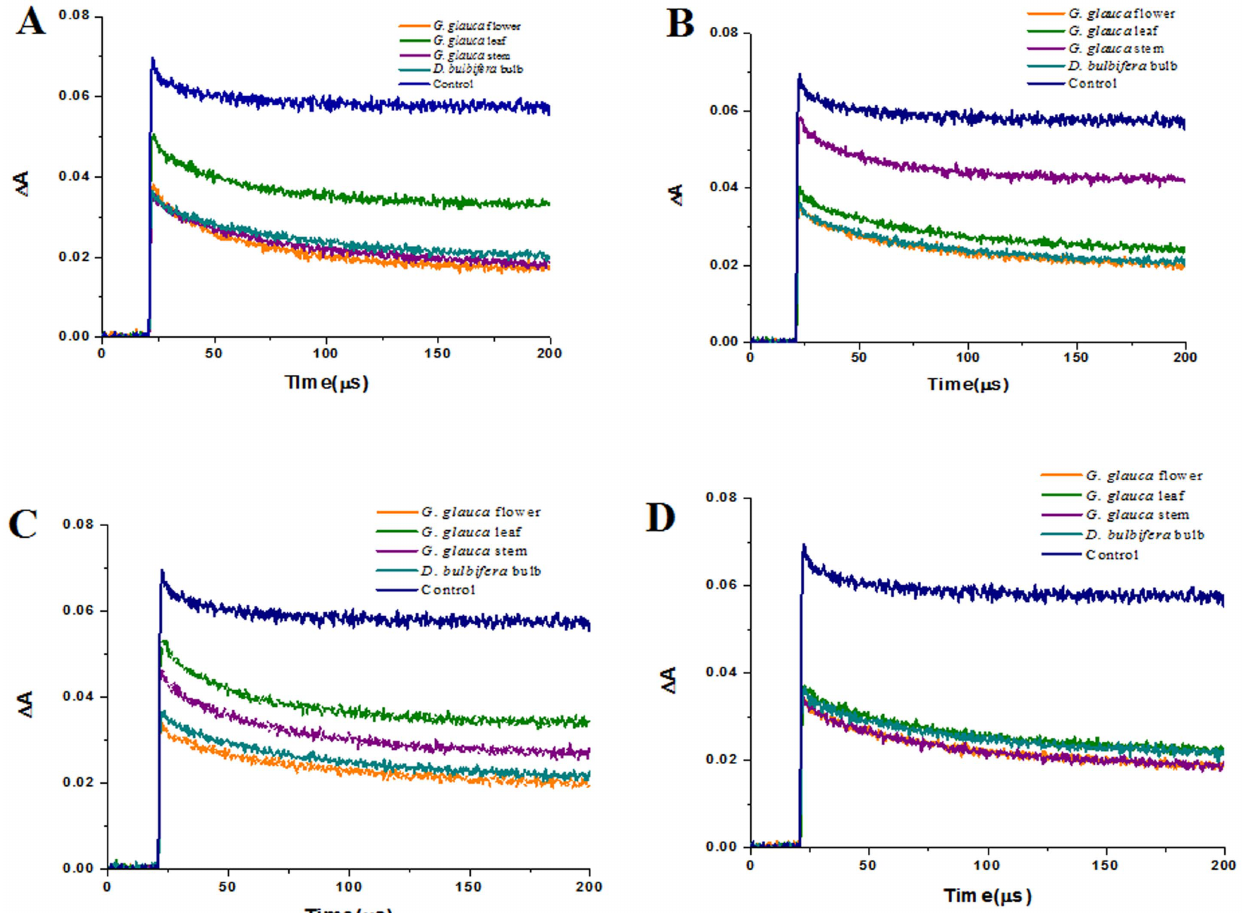
Figure 3. Kinetic decay of pulse radiolysis generated ABTS N + radical by plant extracts. Petroleum ether extracts, (B) Ethyl acetate extracts, (C) Methanolic extracts and (D) Ethanolic (70% v/v) extracts.